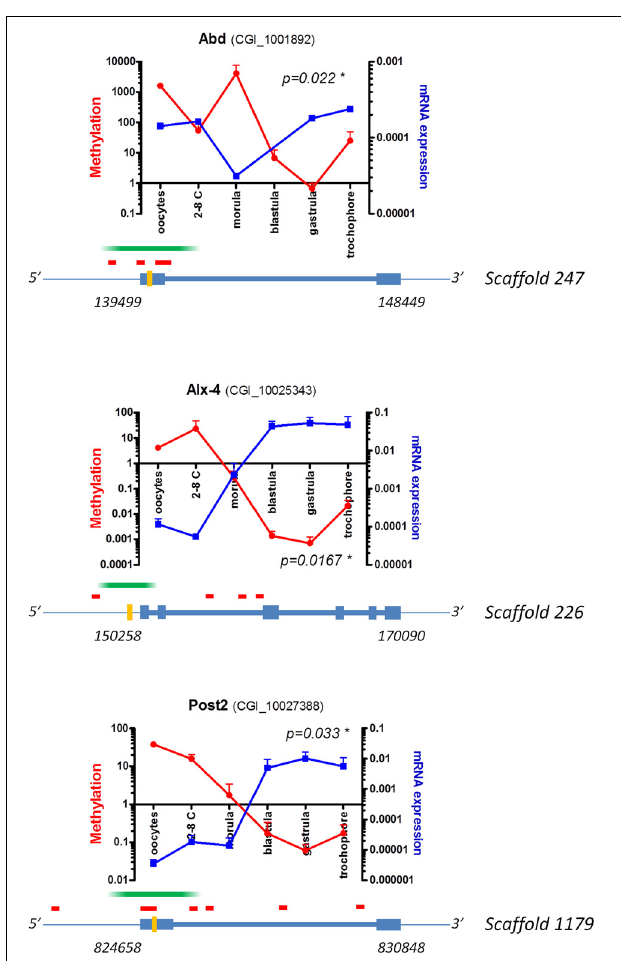
FIGURE 1 | The methylation of 5 (cid:2) regions can drive transcriptional repression during oyster development. Examples of development genes showing patterns suggestive of DNA methylation bias in upstream domains. DNA methylation (red) investigated by MeDIP-qPCR and cognate mRNA expression (blue) measured by RT-qPCR are shown for the C. gigas Abd , Alx4 and Post2 putative orthologs (development stages and GenBank accession numbers are indicated). The diagrams represent the genomic and methodological contexts. Scaffold numbers correspond to the fragment considered in the present assembly of the oyster genome (Zhang et al., 2012), start and stop positions (italic); intergenic (thin line), introns (thick line), exons (rectangles), putative MeDIPped fragments (green), qPCR amplified regions (orange), and CpG islands (red) are represented (modified from Riviere et al., 2013). ∗ p < 0 . 05 Pearson or Spearman’s correlation test between methylation and mRNA